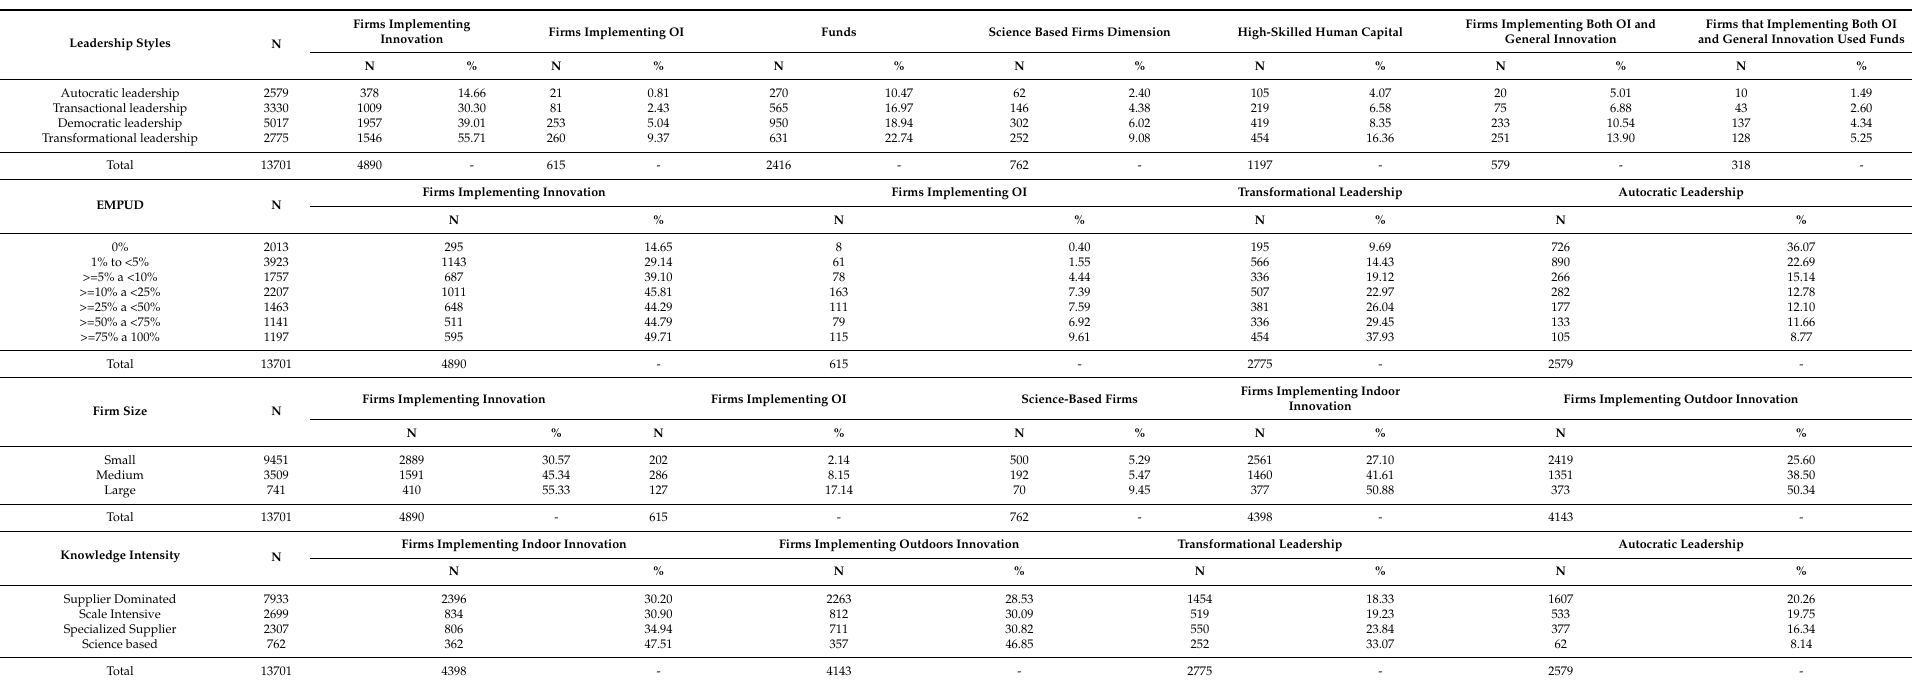
Table 2. Summary of exploratory